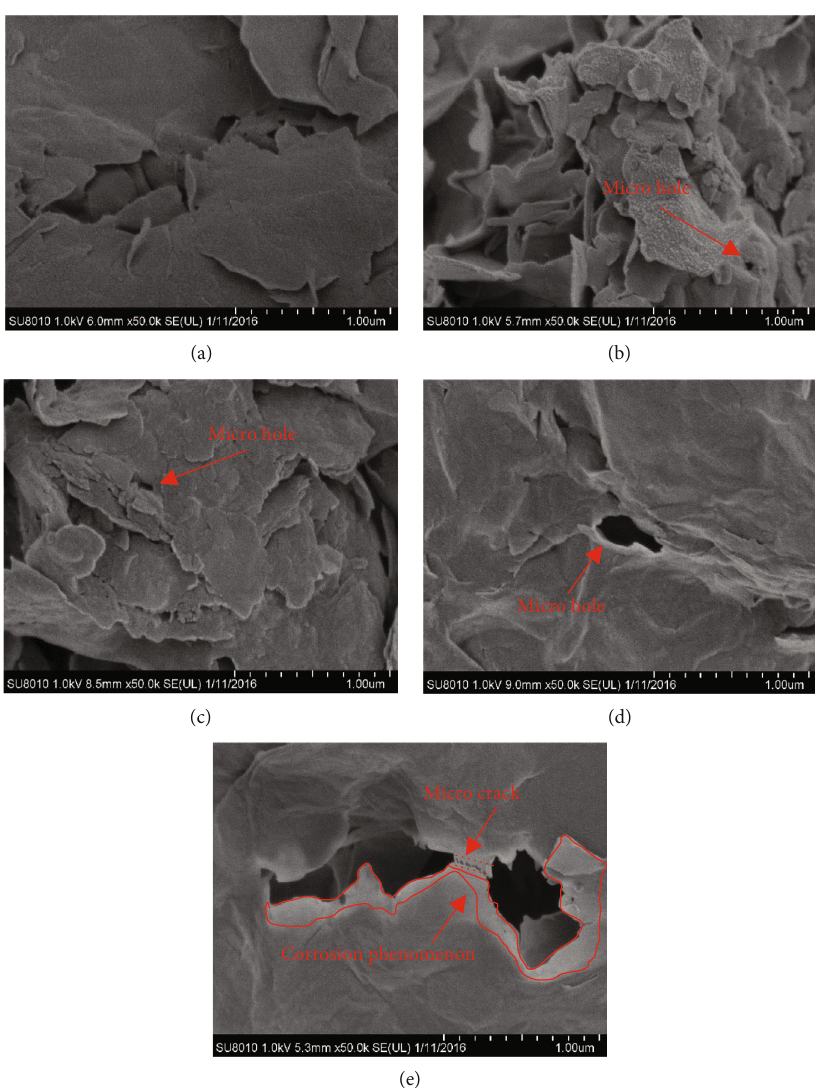
Figure 7: SEM pictures of rock samples under di ff erent water contents under ((a) dry state, (b) 7% water content, (c) 8% water content, (d) 9% water content, and (e) 10% water content (saturated